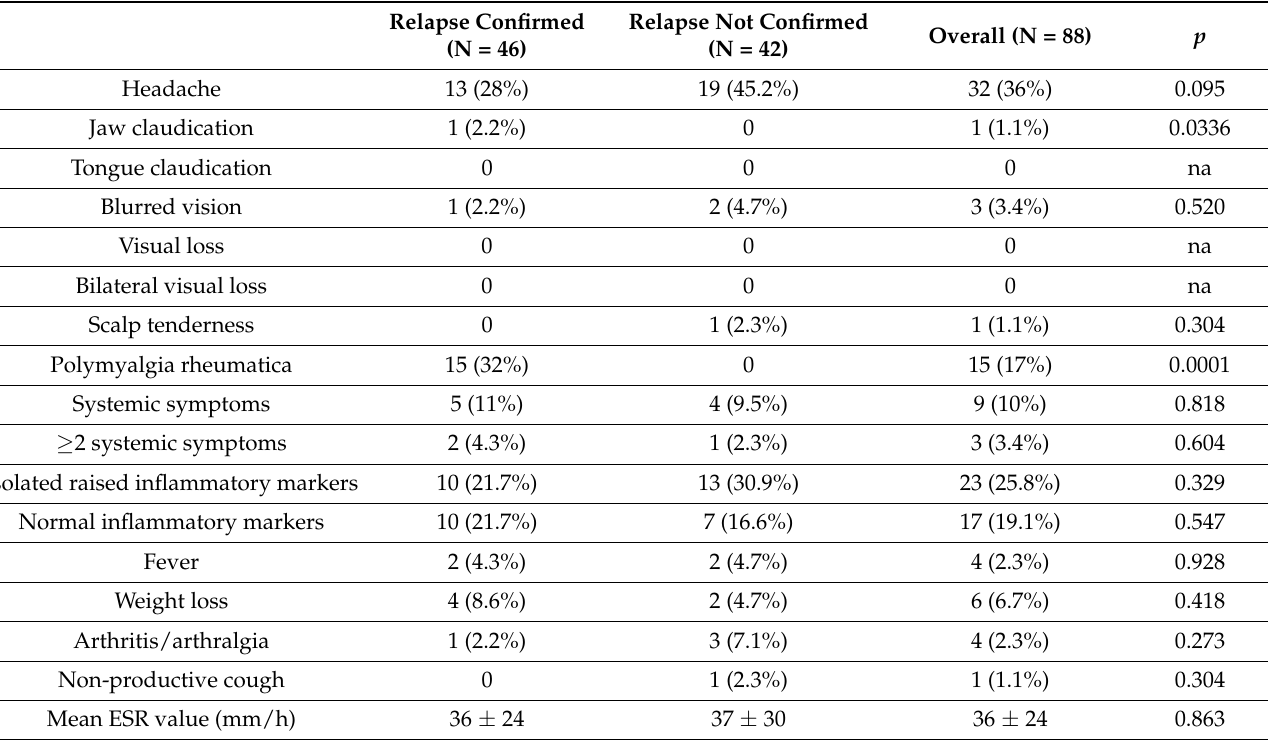
Table 2. Clinical presentation of patients with possible relapse assessed at the fast-track